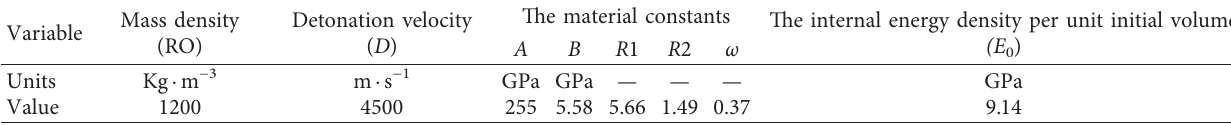
Table 5: Related parameters of the state equation of detonation products.